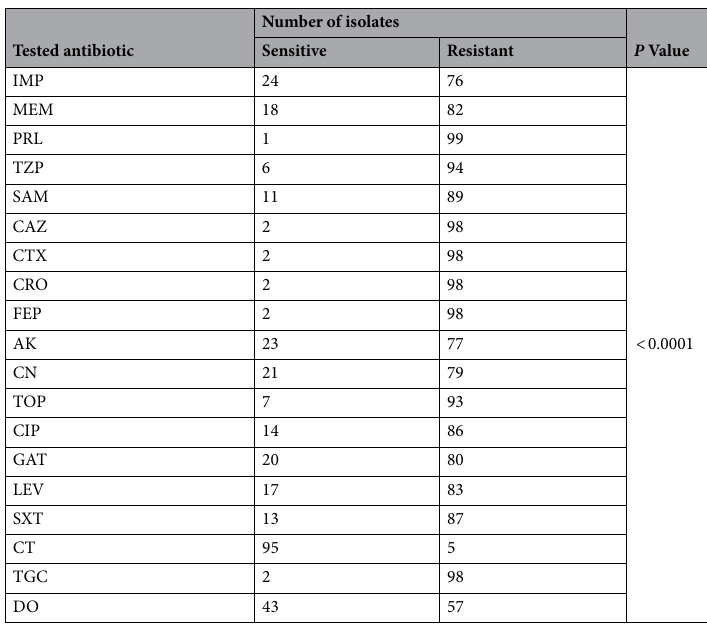
Table 3. Antibiogram analysis of the 100 recovered A. baumannii isolates. IMP: Imipenem, MEM: Meropenem, PRL: Piperacillin, TZP: Tazopactam/Piperacillin, SAM: Sulbactam /Ampicillin, CAZ: Ceftazidime, CTX; Cefotaxime, CRO: Ceftriaxone, FEP: Cefepime, AK: Amikacin, CN: Gentamicin, TOB: Tobramycin, CIP: Ciprofloxacin, GAT: Gatifloxacin, LEV: Levofloxacin, SXT: Sulfamethoxazole/Trimethoprim, CT: Colistin, TGC: Tigecycline, DO: Doxycycline. The p -value for the chi-square statistic for each tested antibiotic is < 0.0001, which is smaller than the alpha level of 0.05.